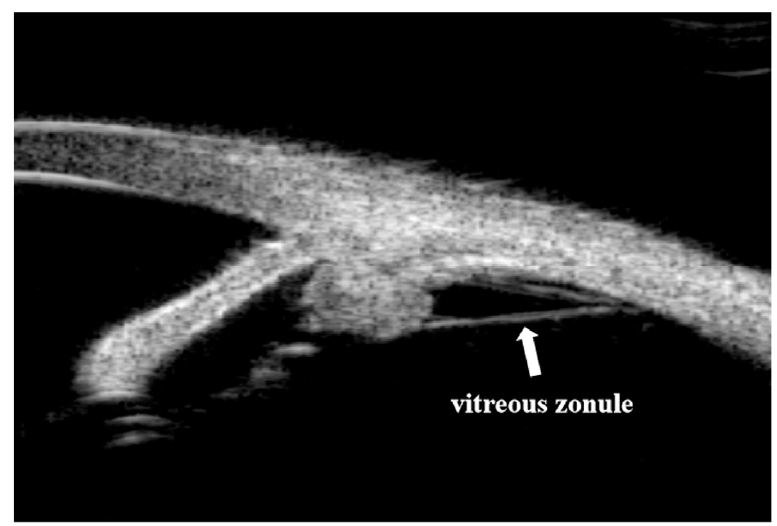
Figure 3. Vitreous zonule (arrows) visible in an ultrasound biomicroscopy (UBM) image of a 63- year-old acute PACG